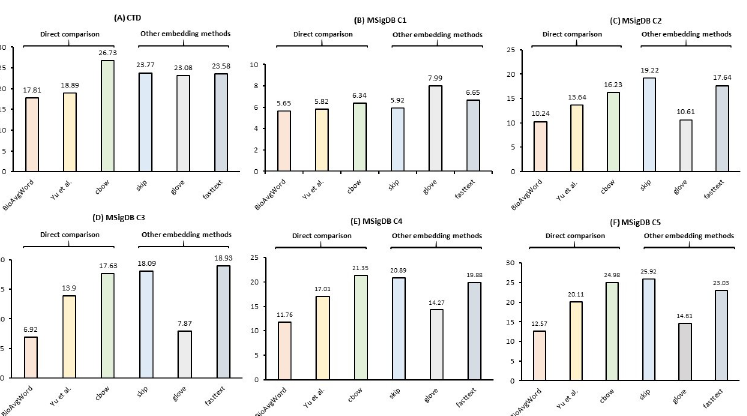
Fig 6. The intrinsic evaluation results for BioConceptVec from different embedding methods (cbow, skip-gram, Glove, and fastText). The embeddings were trained using the same default parameters. Direct comparison: the results of baseline embeddings and BioConceptVec trained using cbow.